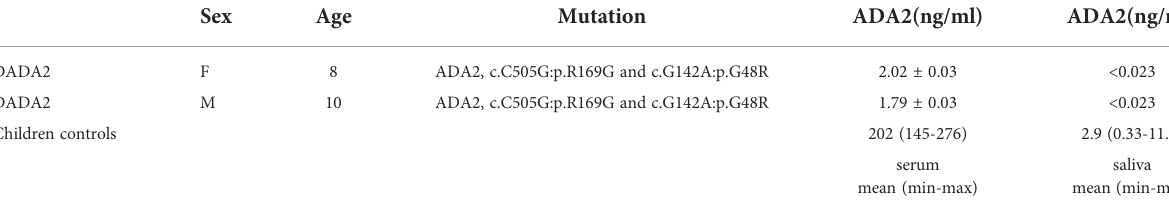
TABLE 3 Saliva and serum samples from DADA2